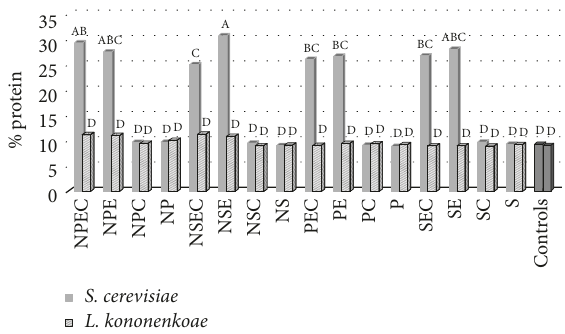
Figure 3: Crude protein by yeast species after 48 hours of fermenta- tion, compared to pasteurized and sterilized controls. N: nitrogen supplement; P: pasteurized; S: sterilized; E: enzyme treatment; C: coculture. Same letters are not significantly different, 𝑝 < 0.05